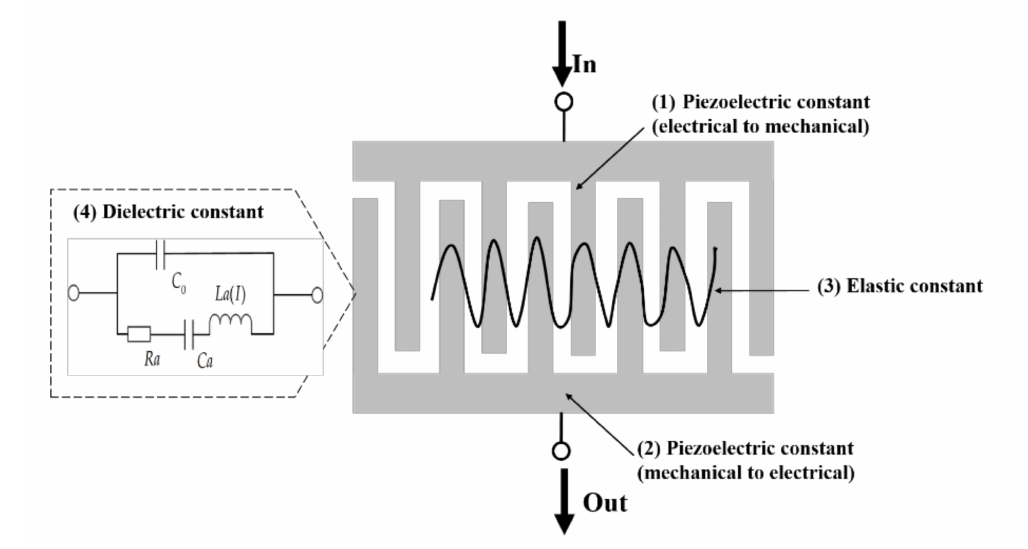
Figure 1. Possible causes of nonlinearity in SAW